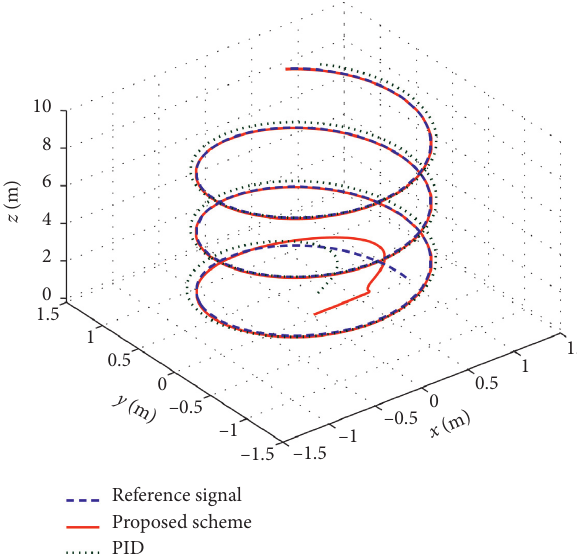
Figure 5: Space diagram of position in the normal